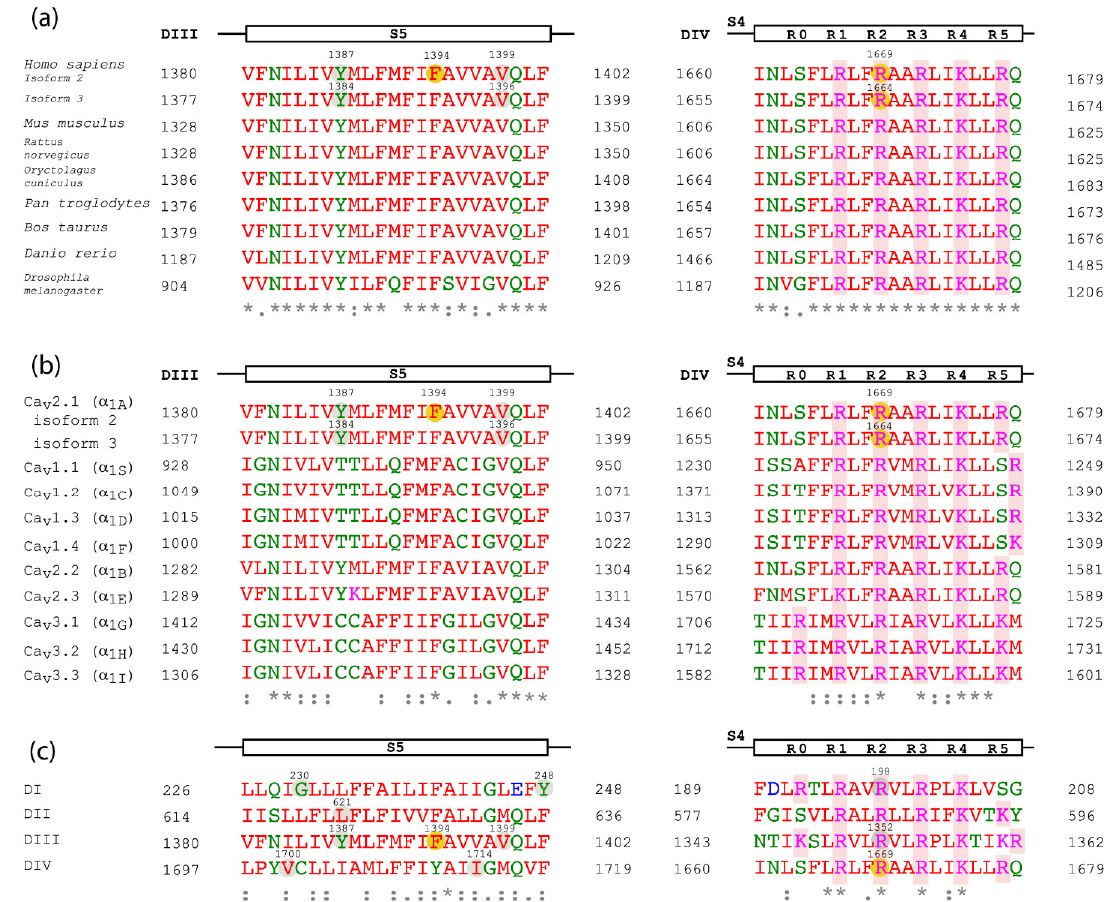
the S5 segment of α 1A domain III (DIII), a few amino acids downstream from the beginning